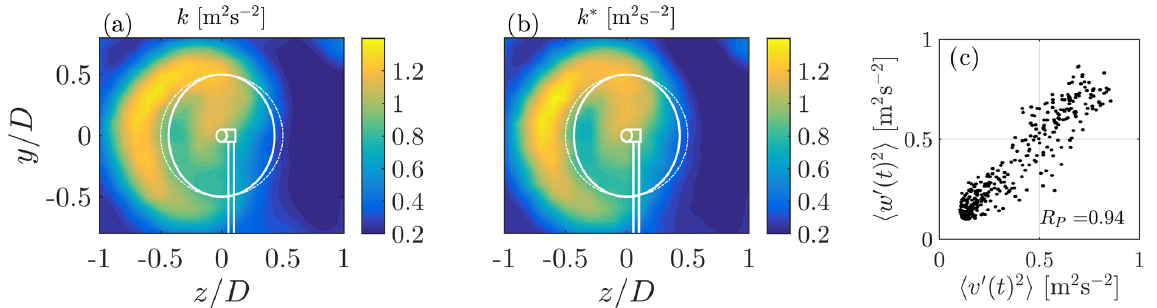
Figure 15. (a) TKE k (cf. Eq. 2), (b) TKE k ∗ (cf. Eq. 4) and (c) (cid:104) v (cid:48) ( t ) 2 (cid:105) vs. (cid:104) w (cid:48) ( t ) 2 (cid:105) for all measurement positions. R P is Pearson’s correlation coefficient. Data are based on a wake 6 D behind the NTNU turbine and γ = 30 ◦